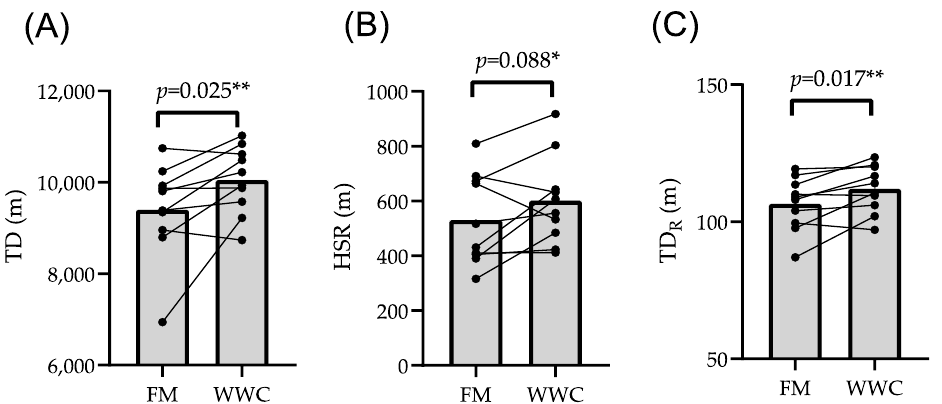
Figure 3. Bar chart with significant differences between periods. FM friendly match; WWC Women world cup; ( A ) TD total distance; ( B ) HSR high speed running; ( C ) TD r total distance relative to the minutes of the match; * effect size small; ** effect size moderate.